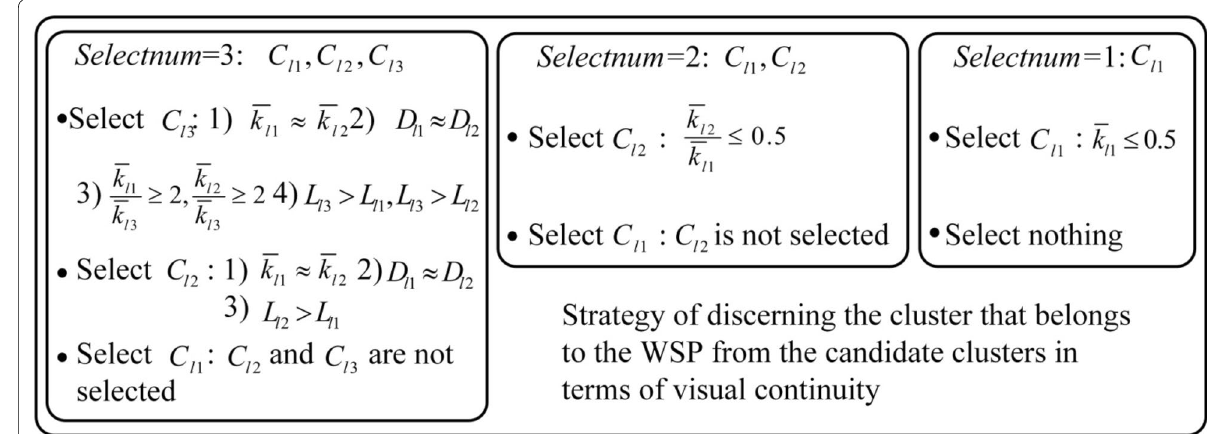
Figure 10 Strategy of discerning the cluster as part of the WSP from the candidate clusters in terms of visual continuity using three kinds of visual features, in which C